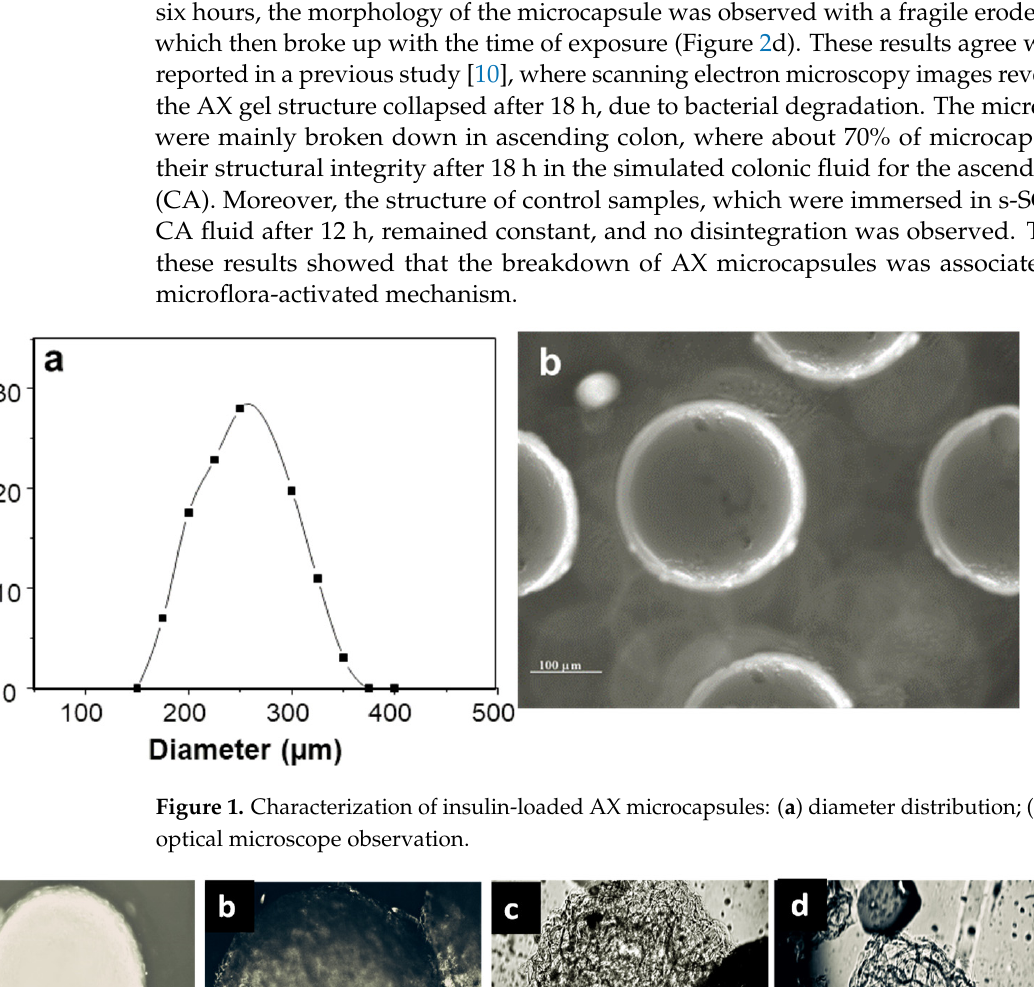
Figure 1. Characterization of insulin-loaded AX microcapsules: ( a ) diameter distribution; ( b ) contrast optical microscope observation.